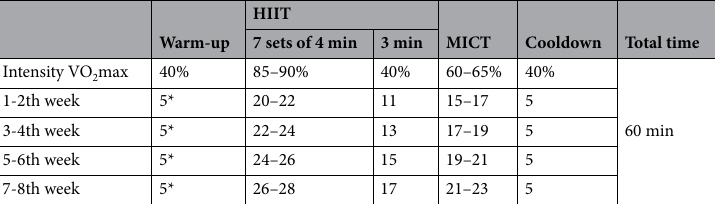
Table 1. Protocol of exercise training. * Meter/Minute: The intensity is expressed in meter/minute and the duration in minutes (min). HIIT high intensity of interval training, MICT moderate intensity of continues